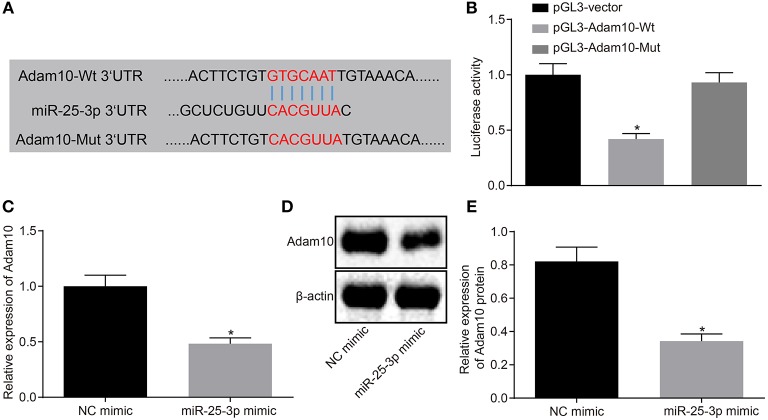
Adam10 is identified as a target gene of miR-25-3p. (A) The binding sites between miR-25-3p and Adam10 predicted by miRDB website. (B) Measurement of luciferase activity in response to the transfection of miR-25-3p mimic, as verified by dual-luciferase reporter gene assay. (C) mRNA level of Adam10 in response to the treatment of miR-25-3p mimic, as measured by RT-qPCR. (D,E) Protein bands and levels of Adam10 in response to the treatment of miR-25-3p mimic, as determined by Western blot analysis; *p < 0.05 vs. the NC mimic group. The measurement data are expressed as mean ± standard deviation and data between two groups were analyzed using independent sample t-test while comparisons among multiple groups were conducted using one-way ANOVA. The experiment was repeated three times independently.